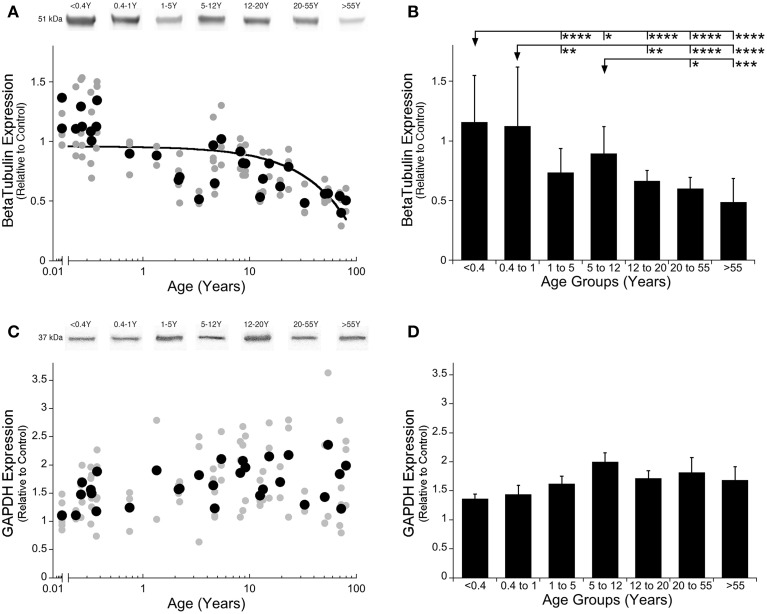
β-Tubulin and GAPDH expression levels in human primary visual cortex across the lifespan. Expression levels of β-Tubulin (A,B) and GAPDH (C,D) are relative to control, and plotted in scatterplots and age-grouped histograms. In the scatterplots (A,C), gray symbols indicate values from individual runs, black symbols indicate the average between runs. Age is plotted on a logarithmic scale. Example bands from representative Western blots are pictured above. In the histograms (B,D), developmental age group means and standard error for each group are plotted. (A) A quadratic function was fit to all β-Tubulin data points across the lifespan (R = 0.567, p < 0.0001). (B) Significant differences among age groups are identified (ANOVA, F = 18.715, p < 0.0001), and Tukey's post-hoc comparisons were made between groups (*p < 0.05, **p < 0.01, ***p < 0.001, ****p < 0.0001). (C) There was no significant change in GAPDH expression across the lifespan. (D) There were no significant differences in expression of GAPDH among the developmental age groups.